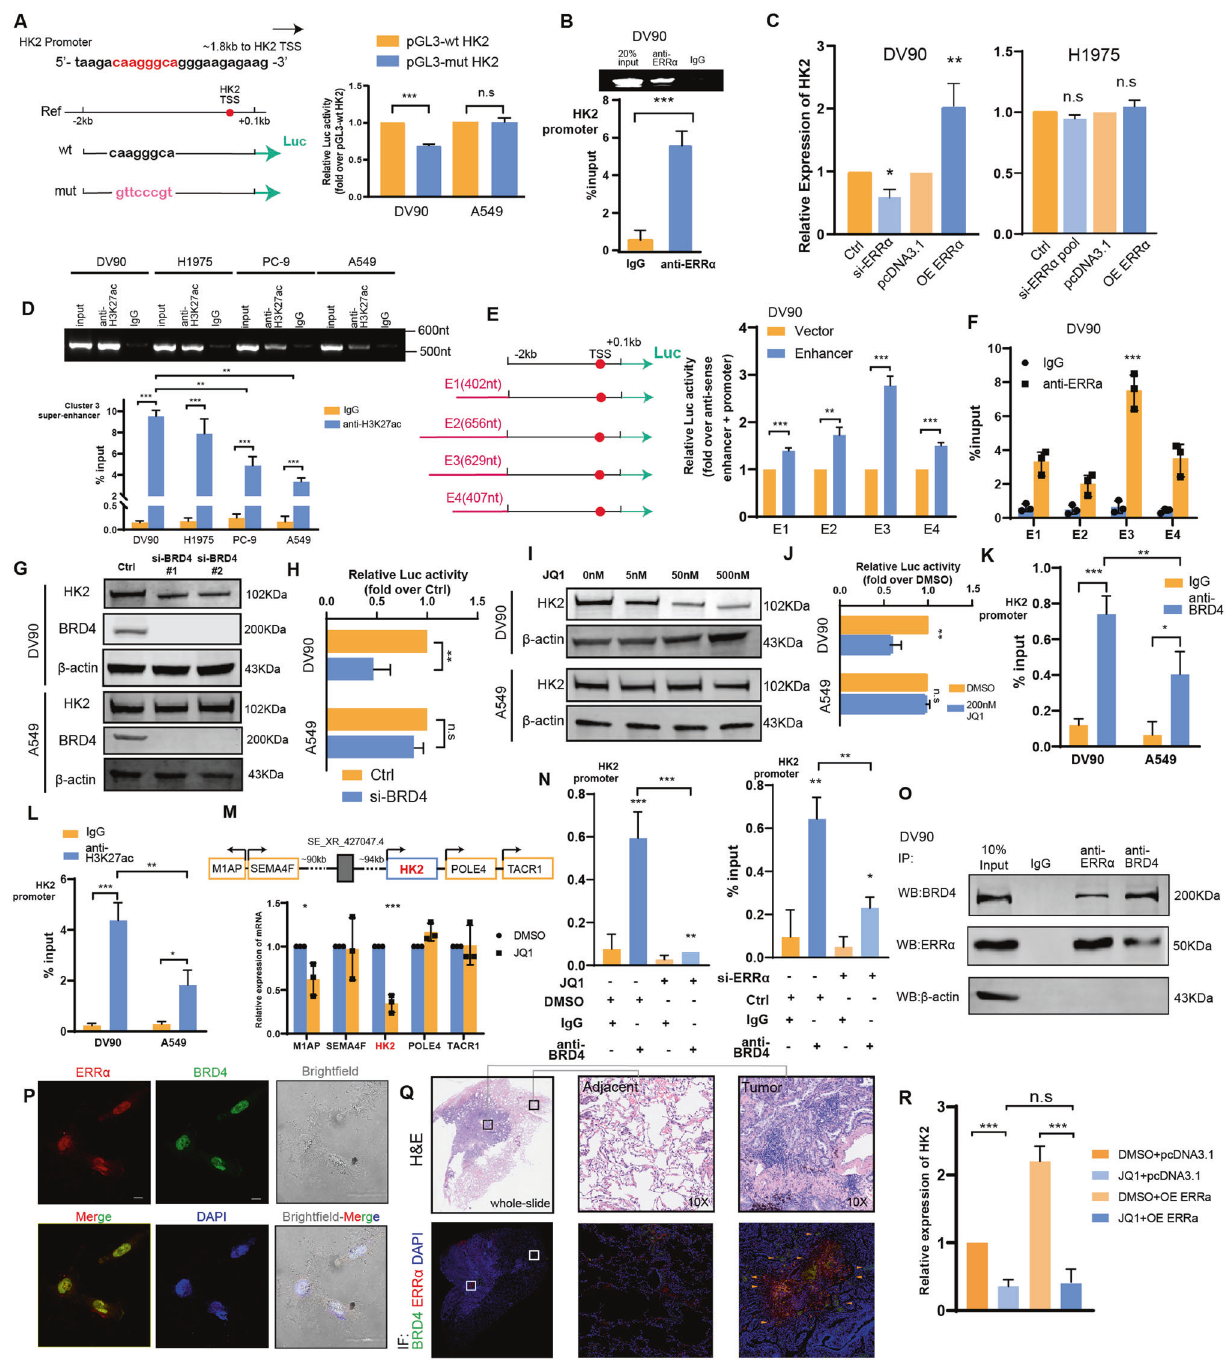
Table S7). Moreover, 91 lung NSCLC cancer cell lines interrogated by genome-wide loss-of-function CRISPR screening [52] revealed that HK2 dependency is greater in tumors with high ERR α dependency than in those with low ERR α dependency (Fig.